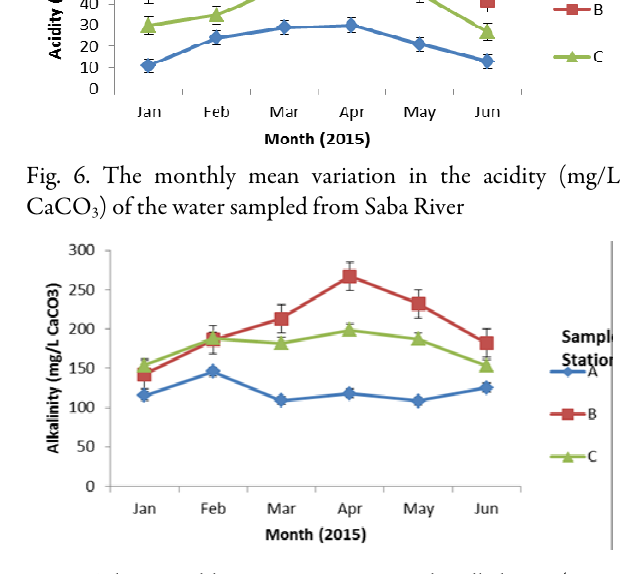
Fig. 7. The monthly mean variation in the alkalinity (mg/L CaCO ) of the water sampled from Saba River 3